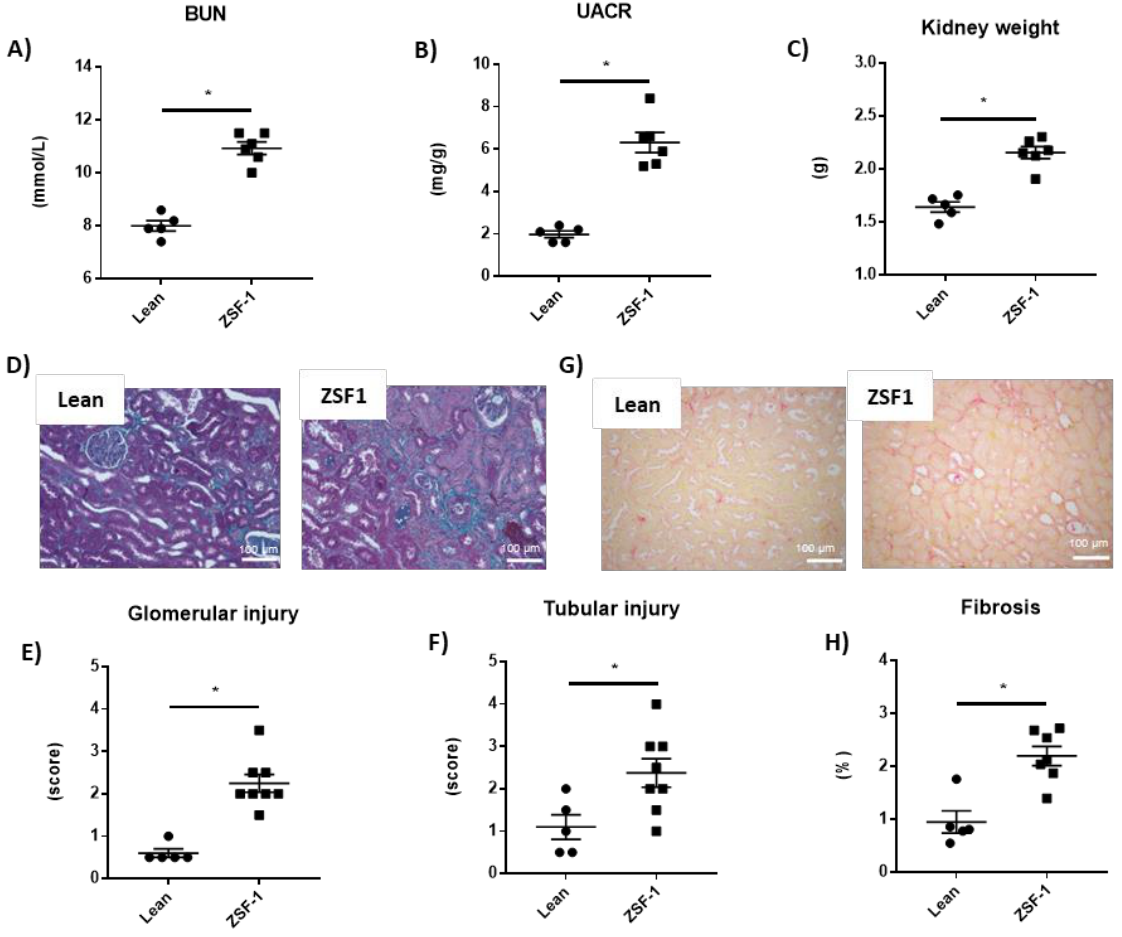
Figure 1. Renal injury developed in obese ZSF-1 rats after 12 weeks. Blood urea nitrogen levels ( A ), urine albumin to creatinine ratio ( B ), and kidney weight ( C ). Representative light microphotographs (20 × magnification) of rat kidney sections stained with Masson Trichrome ( D ) and Sirius red ( G ); glomerular ( E ) and tubular injury quantification ( F ), kidney fibrosis ( H ). Student’s t -test was used for statical analysis, n = 5–8. * p < 0.05 vs. lean.